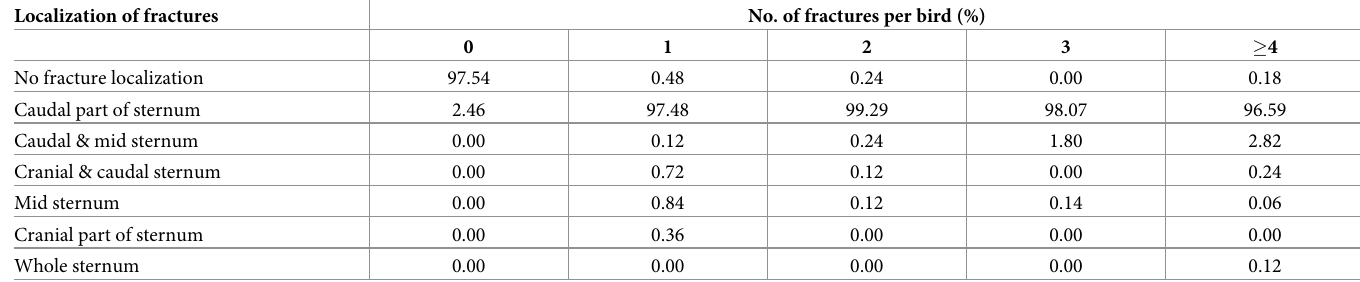
Table 9. Distribution (%) of fracture localization in end of lay hens (n = 4591). The distribution is presented as percentages within columns. Localization of fractures